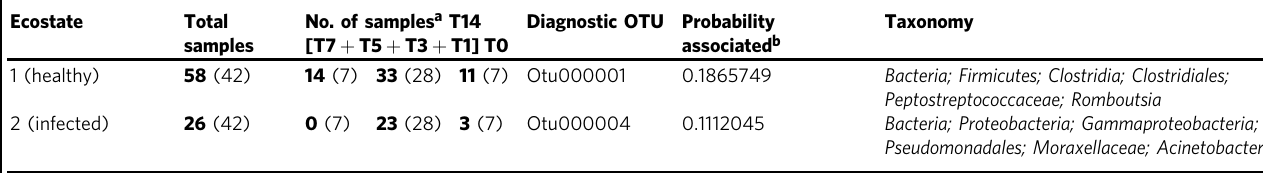
Table 3 Diagnostic microbes for each ecostate from the 1000th iteration of the iDMM model for the ferret samples.